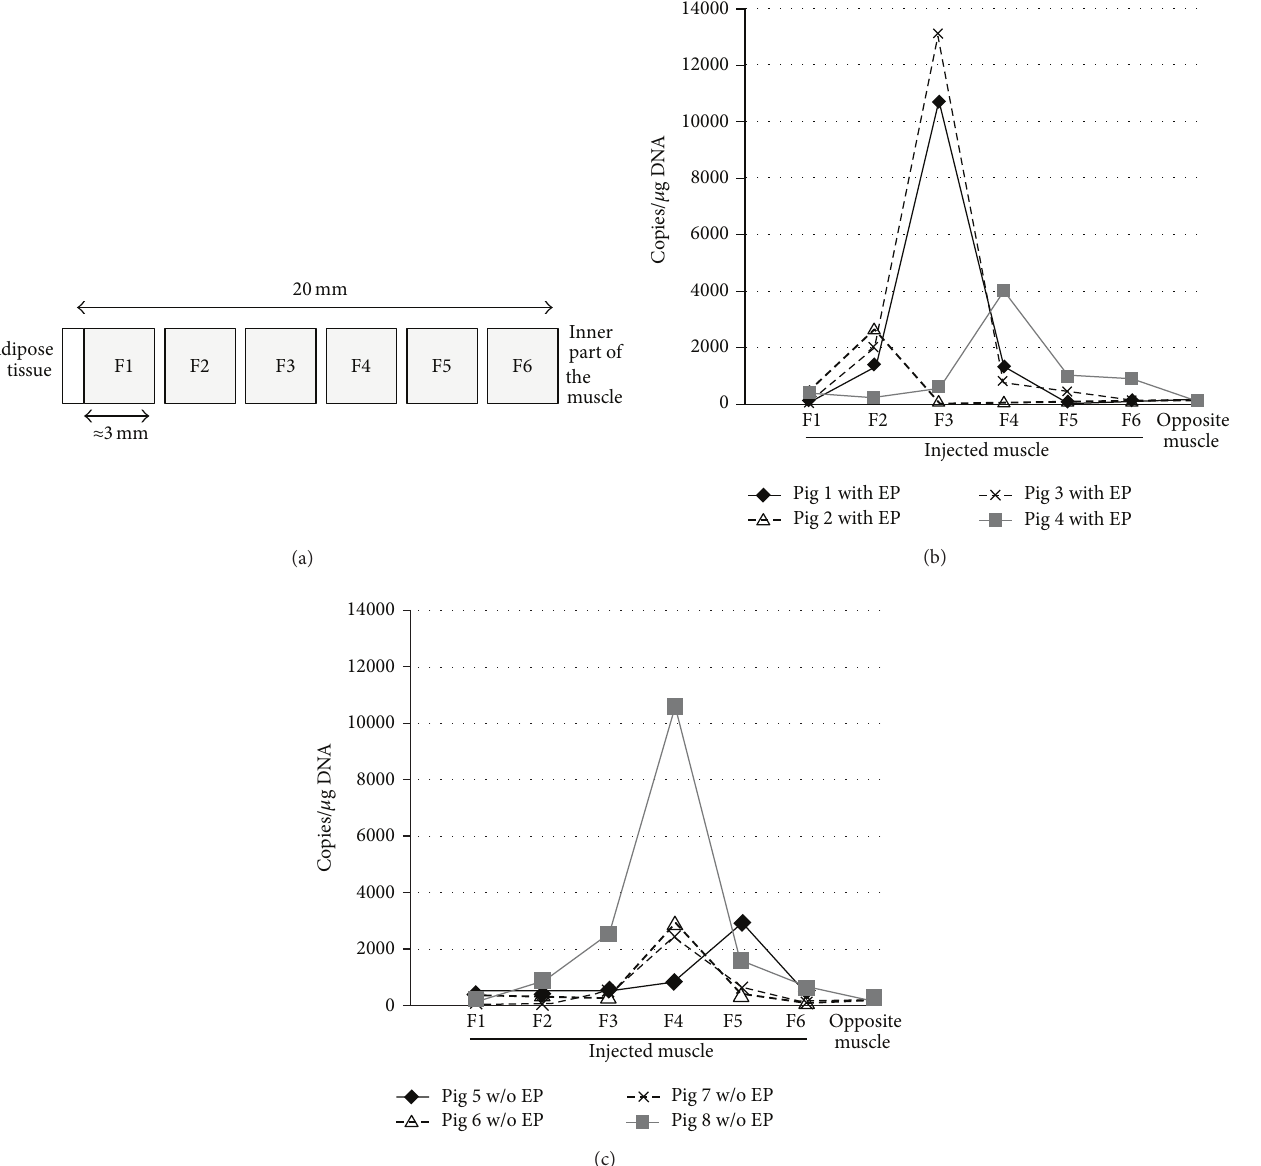
Figure 3: Plasmid concentrations in the different muscle fractions six weeks after injection. Two groups of four pigs were intramuscularly injected with 2.5 × 10 14 copies of PrV-gB-pcDNA3 with or without electroporation, respectively. Six weeks later, excision of the muscle injection site was performed using a disposable 2 cm long and 0.8 cm diameter biopsy punch. (a) The excised muscle portion was divided into six fractions, F1 to F6. Fraction F1 represents the most external part of the muscle (i.e., under the skin) and F6 the most internal part. Thereafter plasmid DNA concentration was measured in each fraction after DNA extraction. Levels (in number of plasmid copies per 𝜇 g of total DNA) of PrV-gB-pcDNA3 present in injected or opposite (noninjected) biceps femoris were quantified by real-time qPCR. Individual plasmid concentrations in each muscle sample for each pig injected with (b) or without (c) electroporation are presented. When taking into account the mean values for each fraction (not shown), the differences between both groups were not statistically significant ( 𝑃 > 0.05 , nonparametric Mann-Whitney